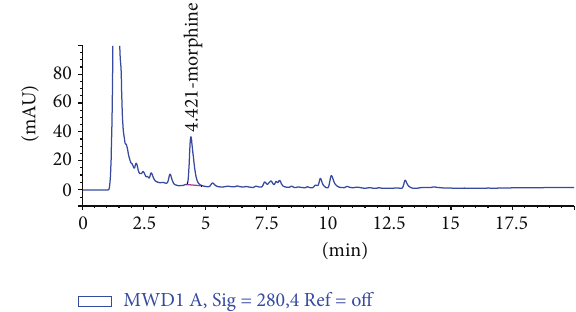
Figure 10: Chromatogram of poppy straw extract (run: 4, concen- tration: 164 𝜇